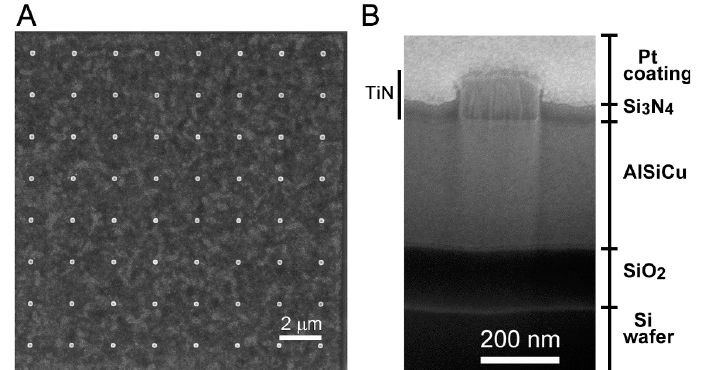
Figure 4. SEM images of 3D-NEA and the single nano-electrode. ( A ) The top view of 3D-NEA. ( B ) The focused ion beam (FIB) image of the cross section view of the nano-electrode in the 3D-NEA with a radius of 0.1 μ m. The organization and distribution of Si wafer, SiO 2 , AlSiCu, TiN electrode, and Si 3 N 4 structures in the CMOS chip are indicated on both sides.